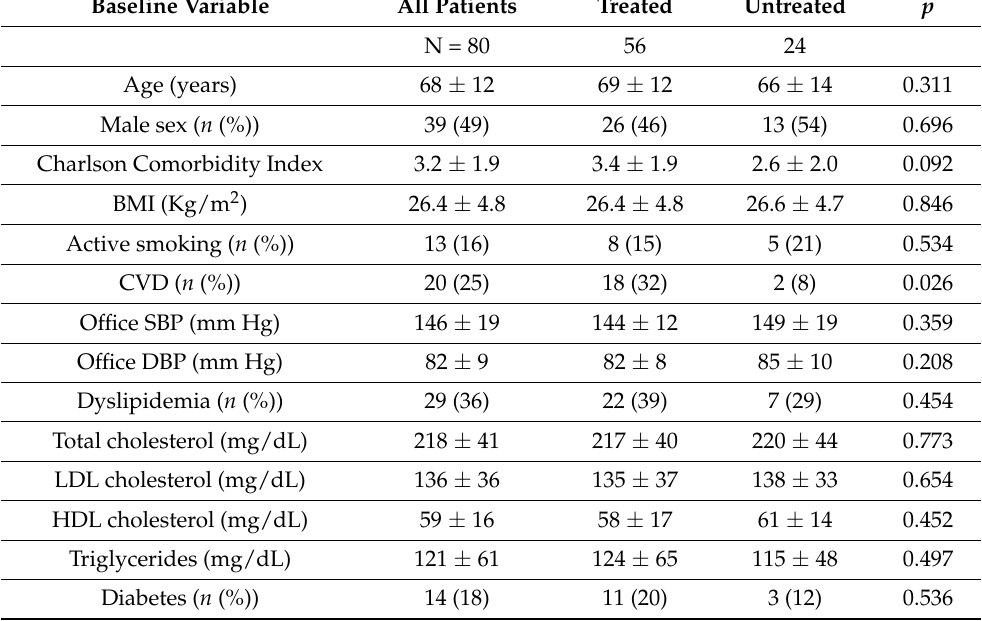
Table 1. General clinical characteristics, laboratory findings, and ophthalmological variables at RVO presentation of patients treated and untreated with antithrombotic